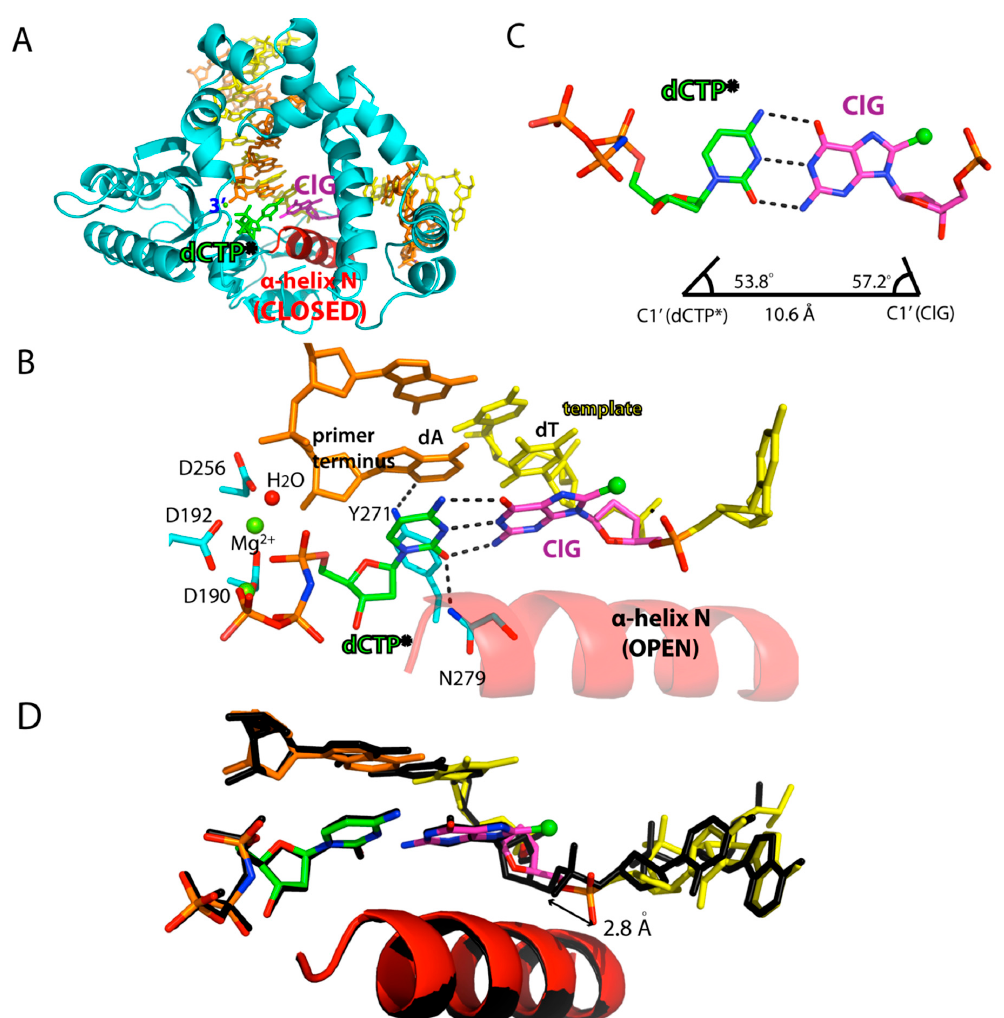
Figure 3. Ternary structure of pol β incorporating non-hydrolyzable dCTP analog opposite templating ClG. ( A ) Overall view of the pol β -ClG:dCTP* ternary complex structure. ClG is shown in magenta and the incoming dCTP* is colored green. The α -helix N, which is shown in red, forms a closed conformation. ( B ) Active-site view of the pol β -ClG:dCTP* ternary complex structure. The templating ClG is an anti -conformation and forms three Watson-Crick hydrogen bonds with incoming dCTP*. The minor groove edges of the incoming dCTP and primer terminus are recognized by Asn279 and Tyr271, respectively. Hydrogen bonds are indicated in dashed lines. Metal cofactors are shown in green spheres and water is shown in red sphere. ( C ) Base pair geometry of dCTP*:ClG in the active site of pol β . ( D ) Superposition of the pol β -ClG:dCTP* structure (multicolor) with the pol β -dA:dUTP* ternary complex structure (black). The distance between the 5 (cid:48) -phosphate oxygen of the templating bases is